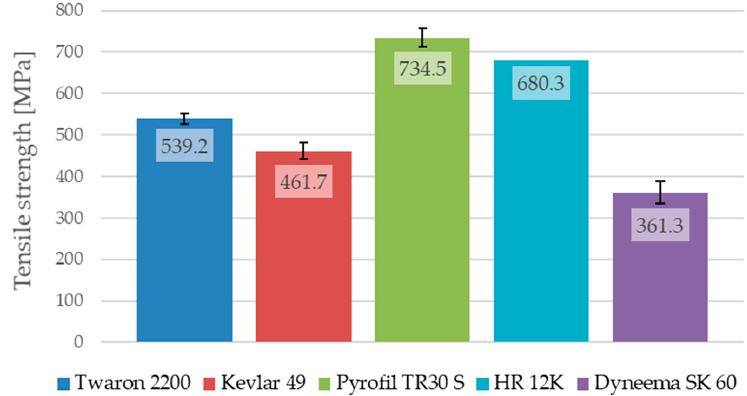
Figure 13. Average tensile strength of the epoxy composites with various reinforcing materials.